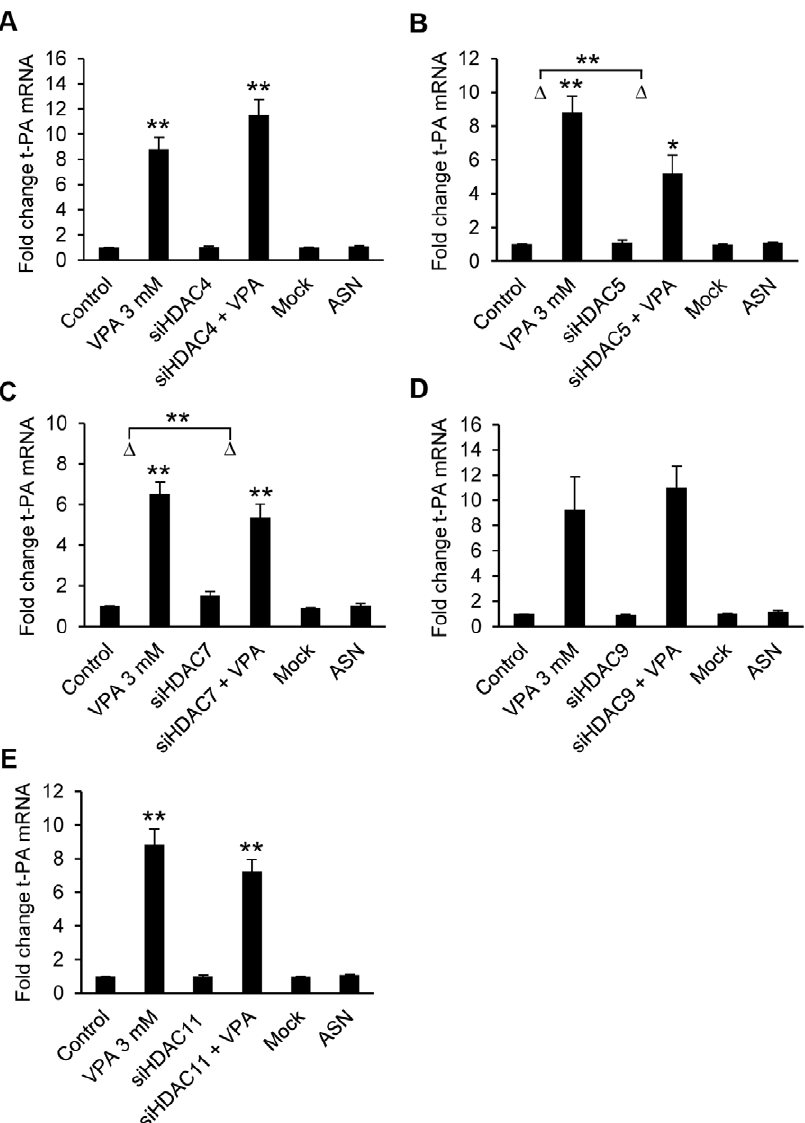
Figure 5. siRNA mediated knock-down of class IIa and class IV HDACs. t-PA mRNA expression in HUVECs treated with A. HDAC4, B. HDAC5, C. HDAC7, D. HDAC9 and E. HDAC11-targeting siRNA for 72 h and then stimulated with 3 mM VPA for 24 h. Mock indicate cells treated with DharmaFECT 4 transfection reagent alone and ASN indicate cells transfected with All Star Negative control siRNA (Qiagen). Unless indicated in the figure, statistical comparisons are made relative to untreated control cells. *p , 0.05, **p , 0.01. The results are presented as mean values 6 SEM of four independent experiments performed in duplicate (HDAC9, n=2).